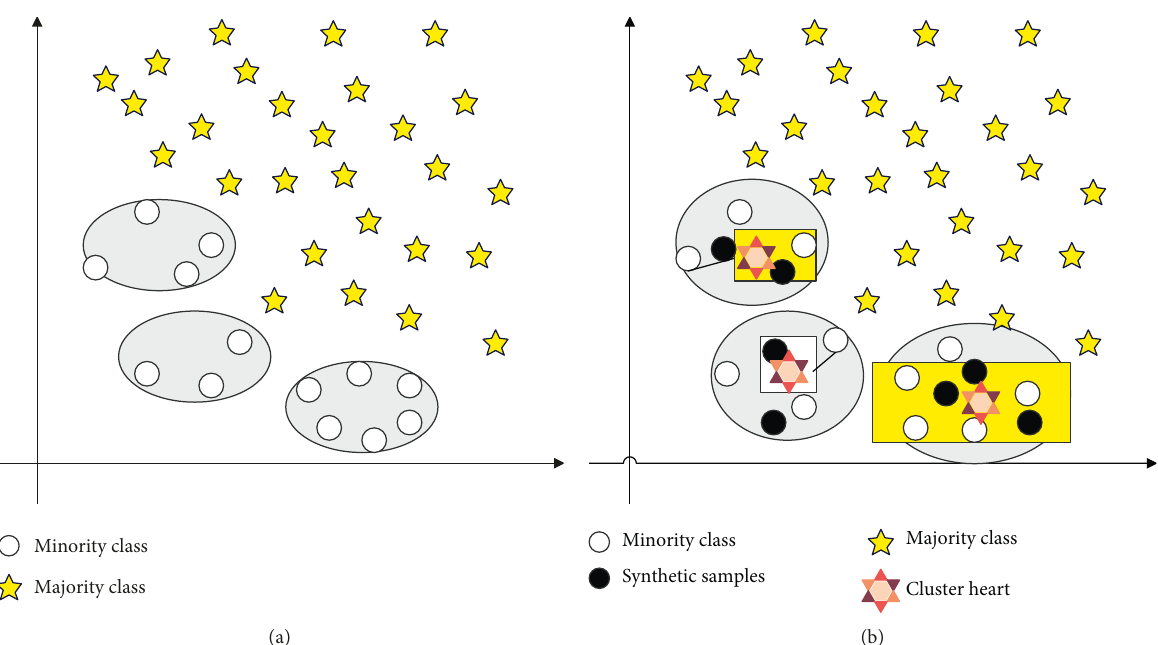
Figure 4: Data clustering and interpolation results. (a) Clusters formed by minority classes (b) RM-SMOTE interpolation